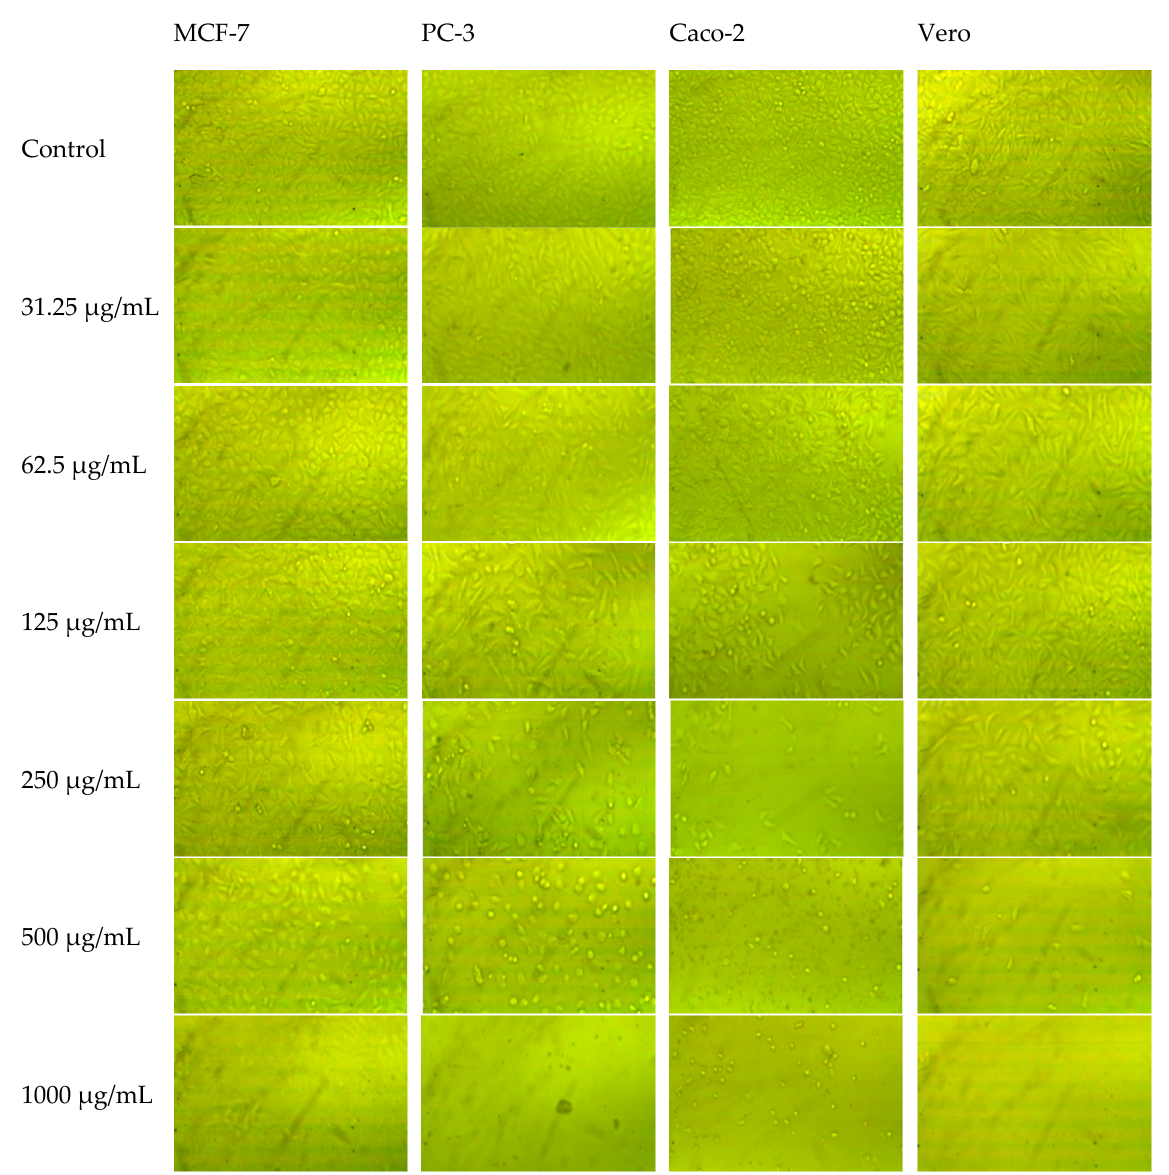
Figure 4. Morphology of MCF-7, PC-3, Caco-2, and Vero cells after 48 h of the treatment with different concentrations of the methanolic extract of neem fruit epicarp.